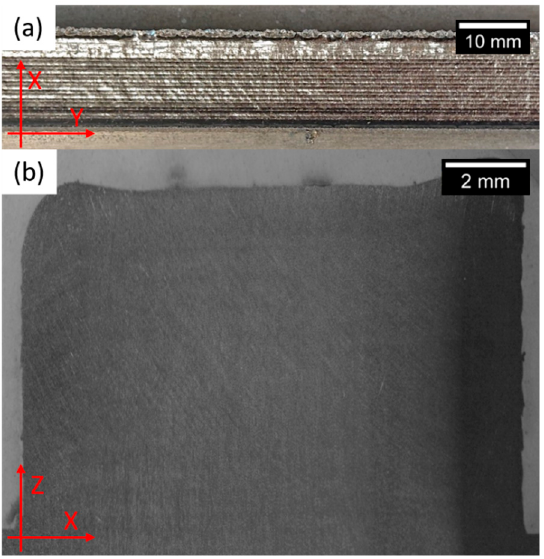
Figure 10. Horizontal bars built in a sealed chamber and using a preheated platform. Top view ( a ) and cross-section ( b ). Similar results were obtained using a non-preheated platform.